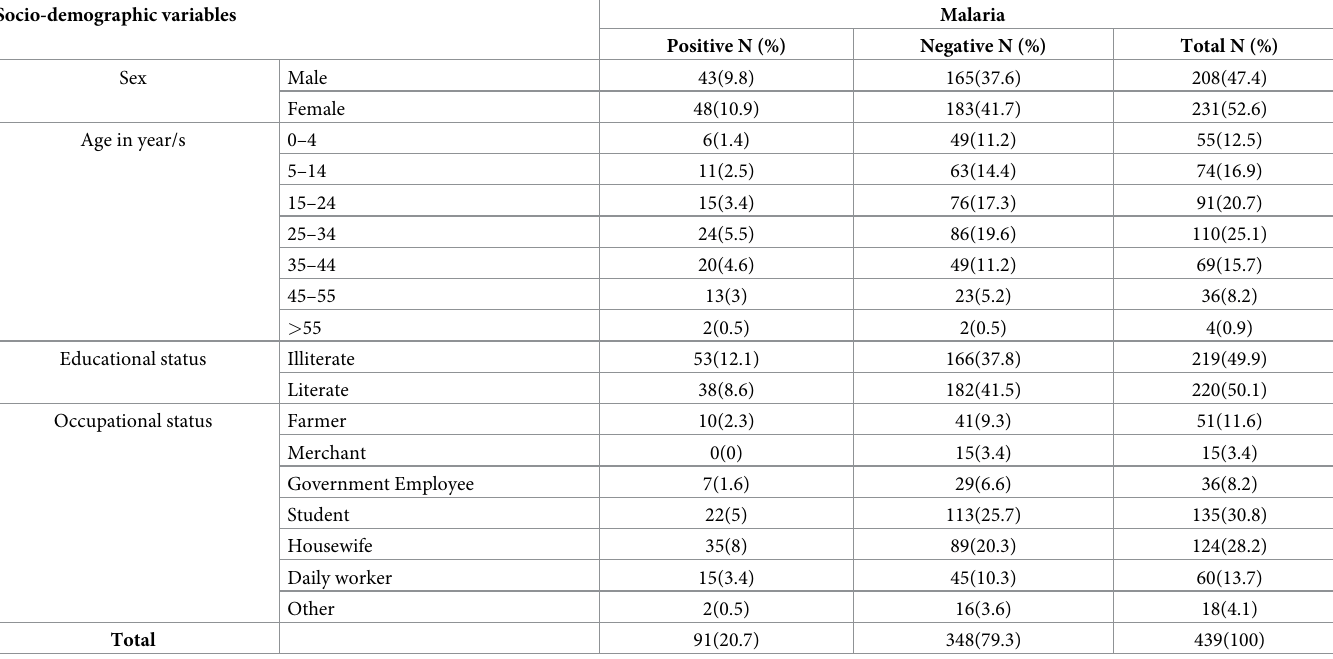
Table 1. Malaria prevalence by sex, age, educational level, and occupation among patients undergoing blood film examination at MTUTH in 2021 (n = 439). Socio-demographic variables